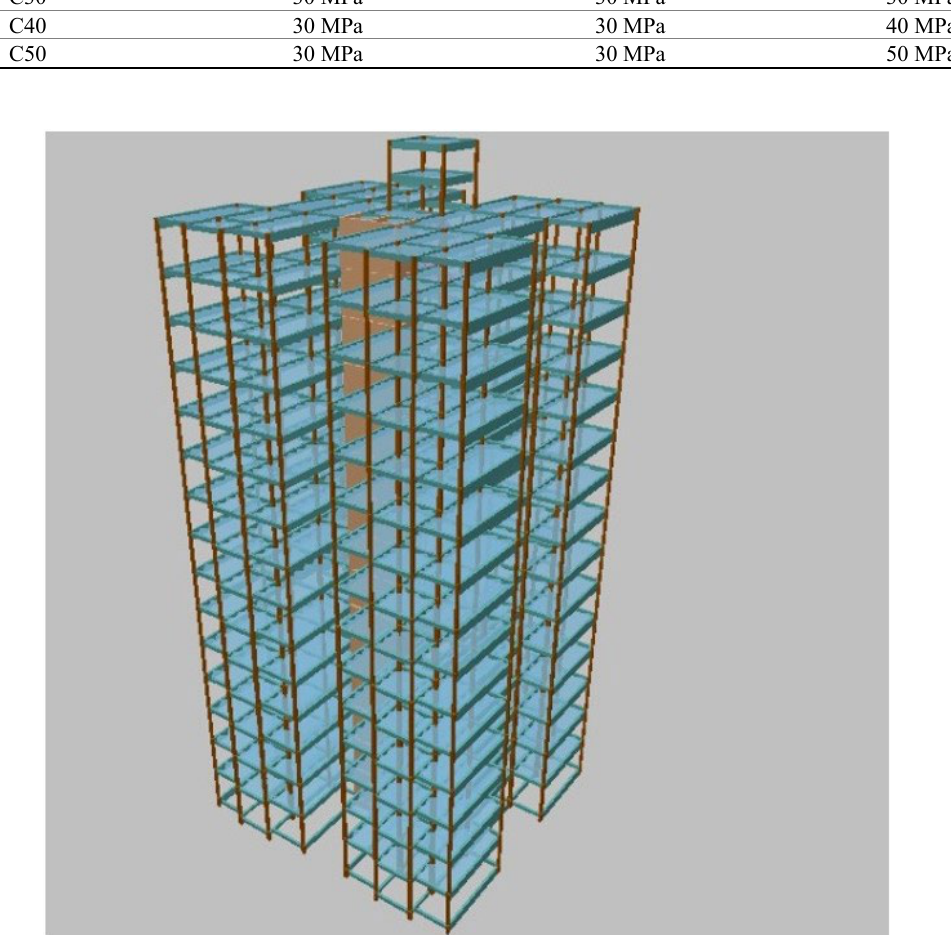
Figure 1. Structural model of the residential